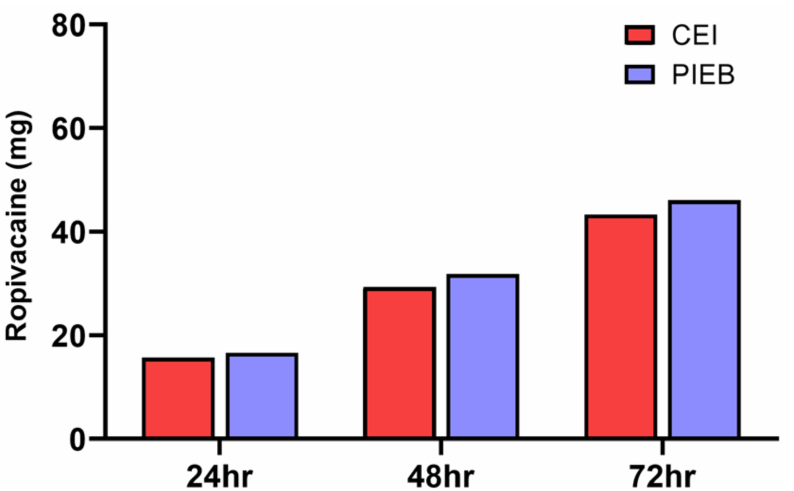
Figure 2. Cumulative consumption of the epidural local anesthetic during the 72 h postoperative period between PIEB and CEI. There was no difference in the epidural local anesthetic consumption between the two groups in 24 h, 48 h, and 72 h after surgery. CEI, continuous epidural infusion; PIEB, programmed intermittent epidural bolus. Data are visualized as bar graph with mean